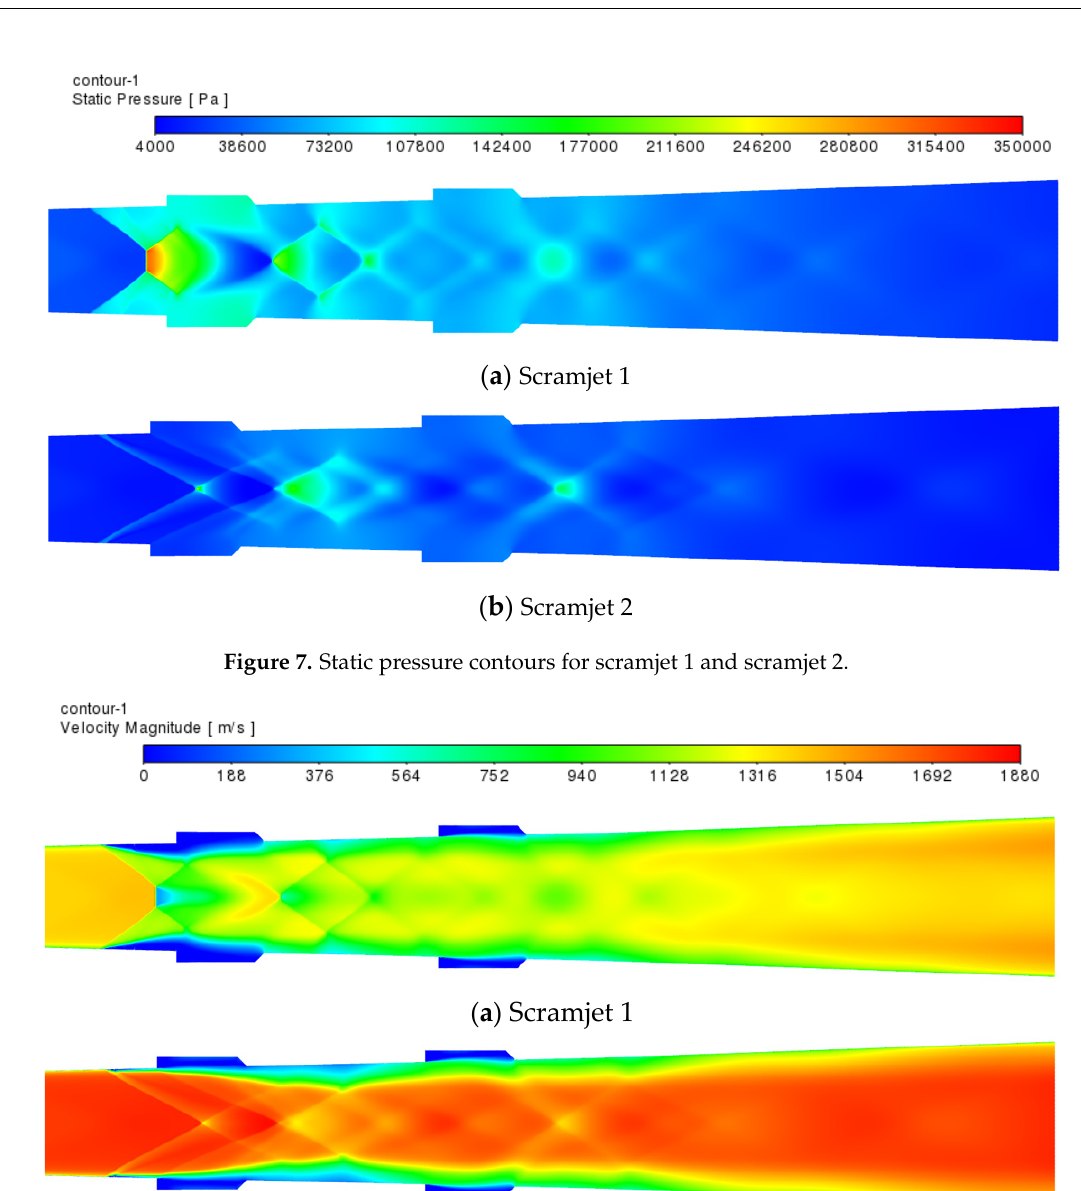
Figure 6. Static temperature contours for scramjet 1 and scramjet 2. 1—Undisturbed zone, 2—Main- stream zone, and 3—Near wall combustion zone.